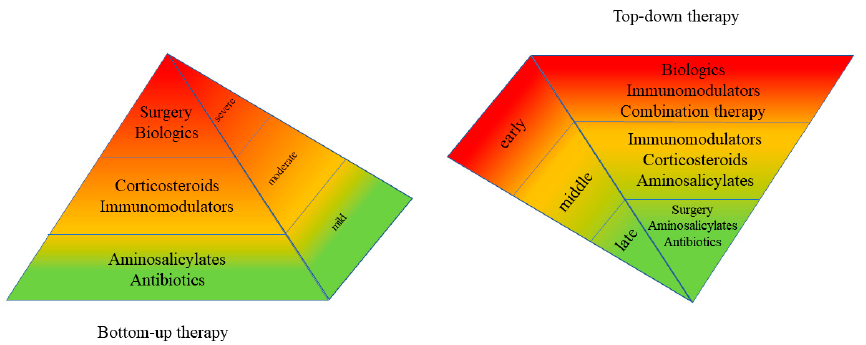
Figure 1. Bottom-up vs. top-down therapy .